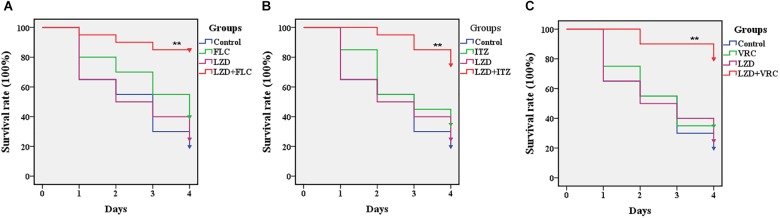
Survival rate of infected Galleria mellonella larvae treated with different drugs. Panels (A–C) are the survival rates of infected Galleria mellonella treated with LZD + FLC, LZD + ITZ, and LZD + VRC, respectively. CA10 (5 × 108 CFU/mL) was used to infect the G. mellonella larvae (20 larvae for each group). After infection, the larvae were treated with sterile PBS, FLC (160 μg/mL), ITZ (40 μg/mL), VRC (40 μg/mL), LZD (200 μg/mL), LZD (200 μg/mL) plus FLC (160 μg/mL), LZD (200 μg/mL) plus ITZ (40 μg/mL), and LZD (200 μg/mL) plus VRC (40 μg/mL), respectively. The data came from the means of three independent experiments and the log-rank test was performed. Compared with the FLC-treated group, ∗P < 0.05, ∗∗P < 0.01.